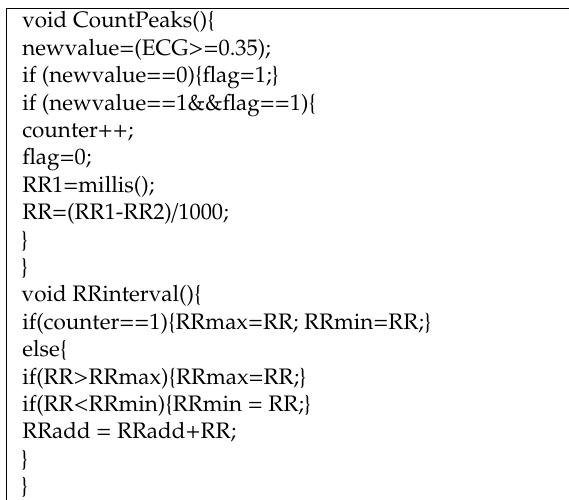
Table 2. The CountPeaks() subroutine and RRinterval() subroutine used to calculate the RR interval.